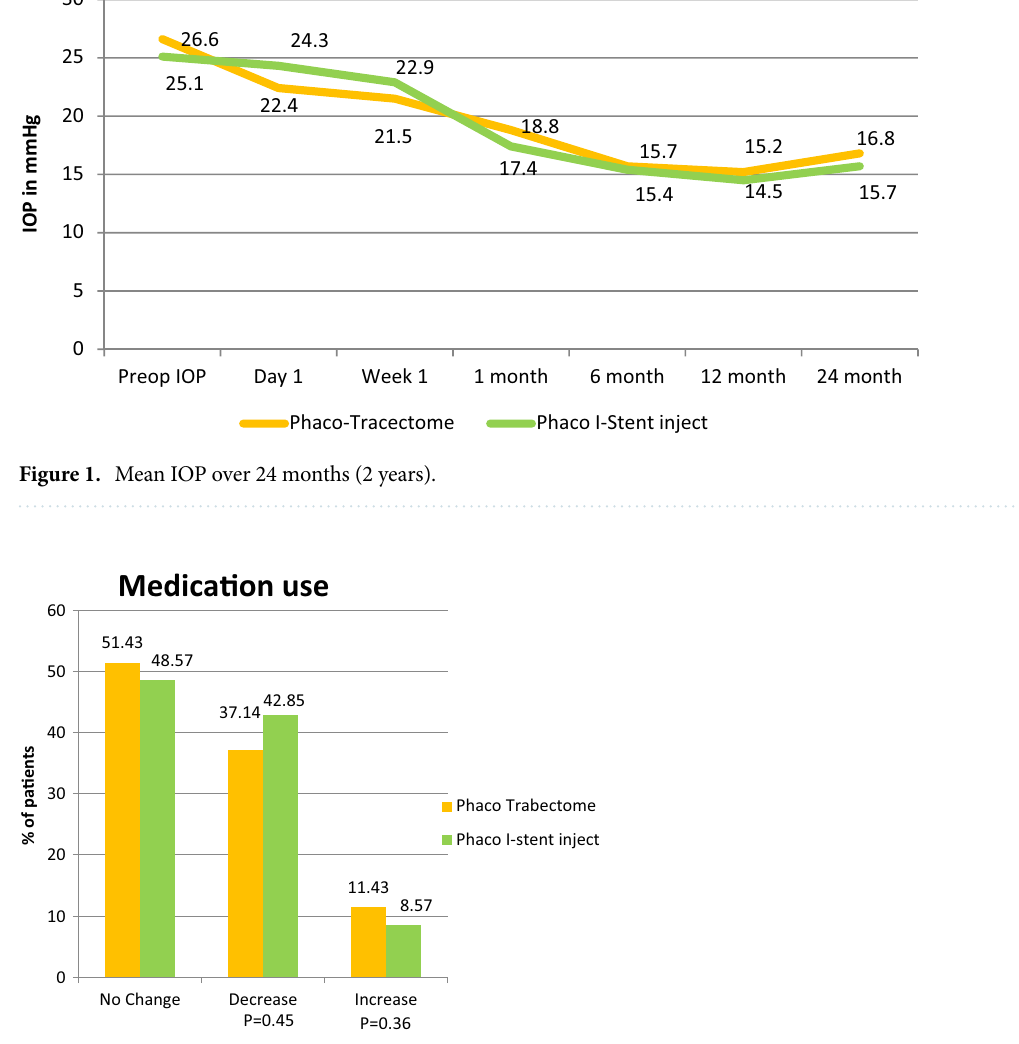
Figure 2. Percentage of patient showing change in Mean number of eye drops at 24 months compared to